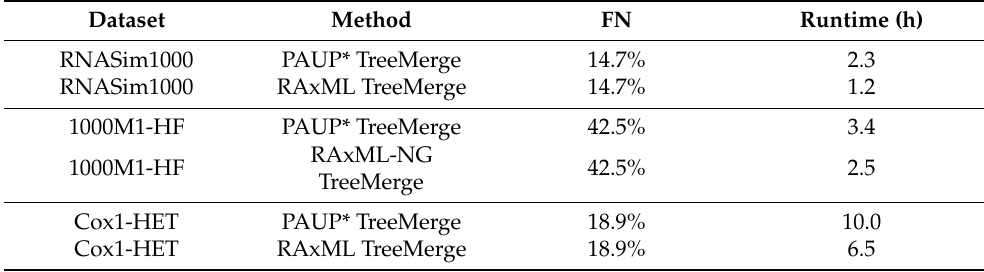
Comparing branch length estimation using RAxML-NG instead of PAUP* inside TreeMerge. Here we show the False Negative error rates of two different variants of TreeMerge, averaged over 10 replicates of Cox1-HET and 5 replicates of RNASim1000 and 1000M1-HF. Using RAxML for branch length calculation benefits run-time while maintaining the same level of tree error. A FastTree starting tree was used with centroid decompositions and maximum subset size 500. TreeMerge was provided with the topological distance matrix computed from the FastTree starting tree. The runtime reported is for the whole pipeline from constructing the starting tree to getting the final TreeMerge tree where RAxML was allowed to have 2 cores, constraint tree calculations for both TreeMerge variants were considered to have been run in parallel up to 16 cores. Otherwise the steps are sequential, including the starting tree calculation, constraint tree calculation, and